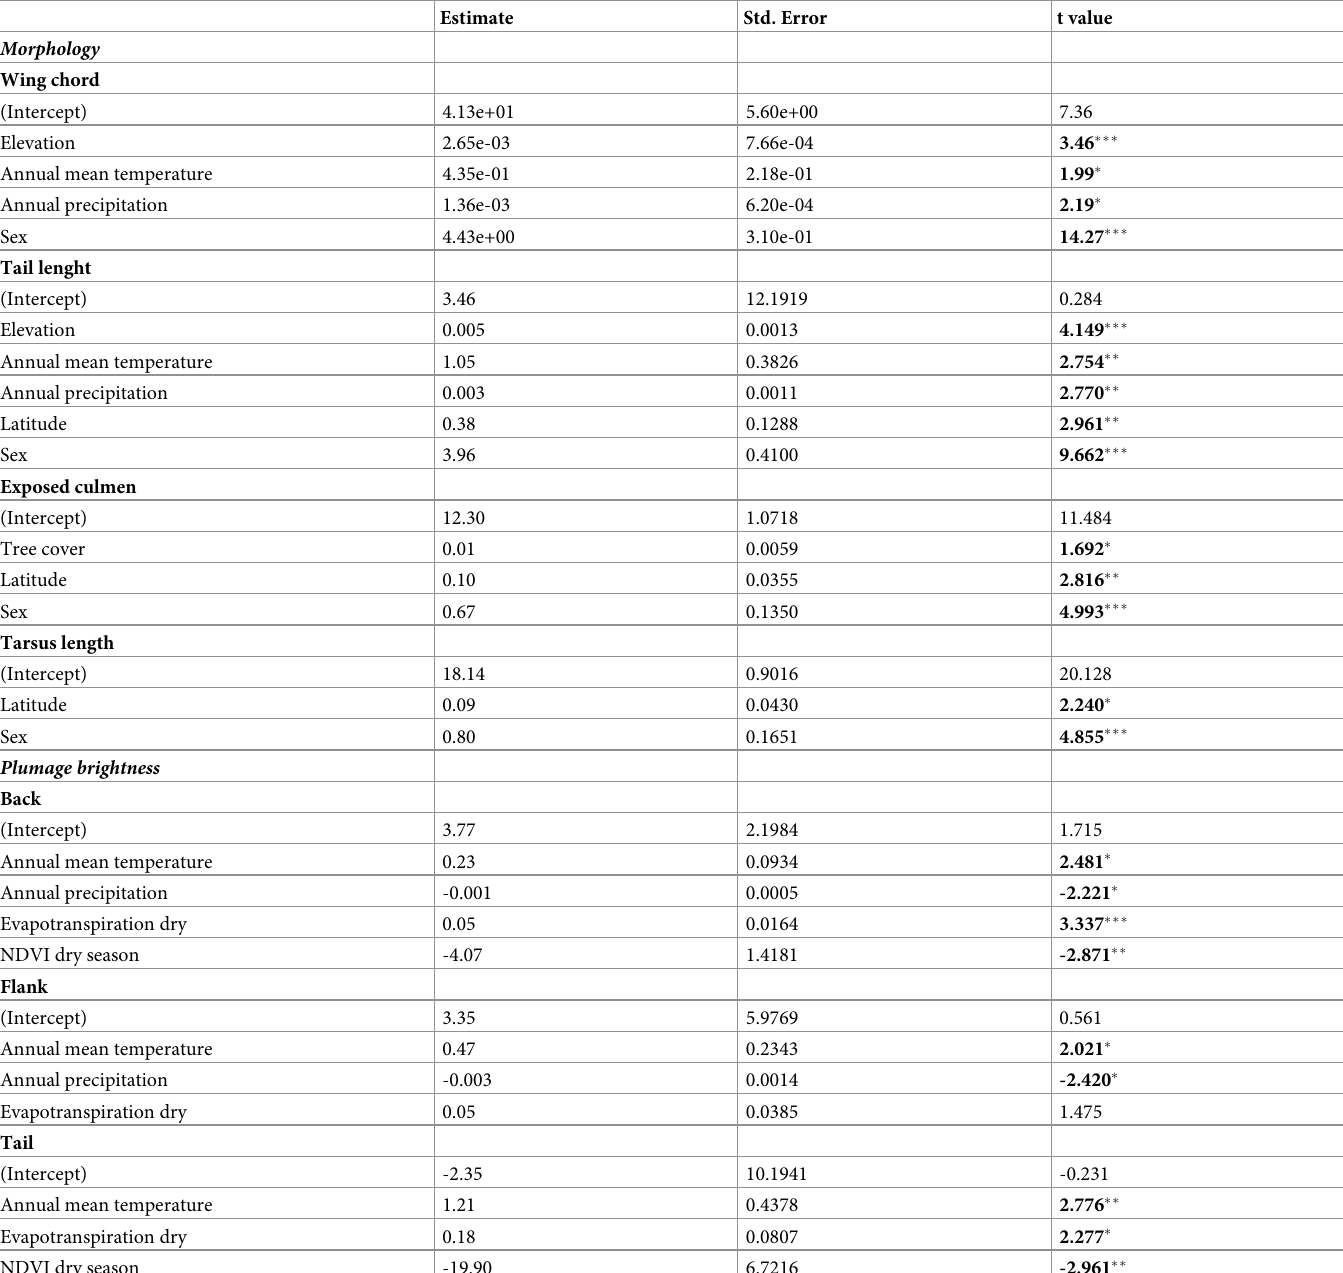
Table 3. Mixed effects models over phenotypic traits of Thryophilus sinaloa